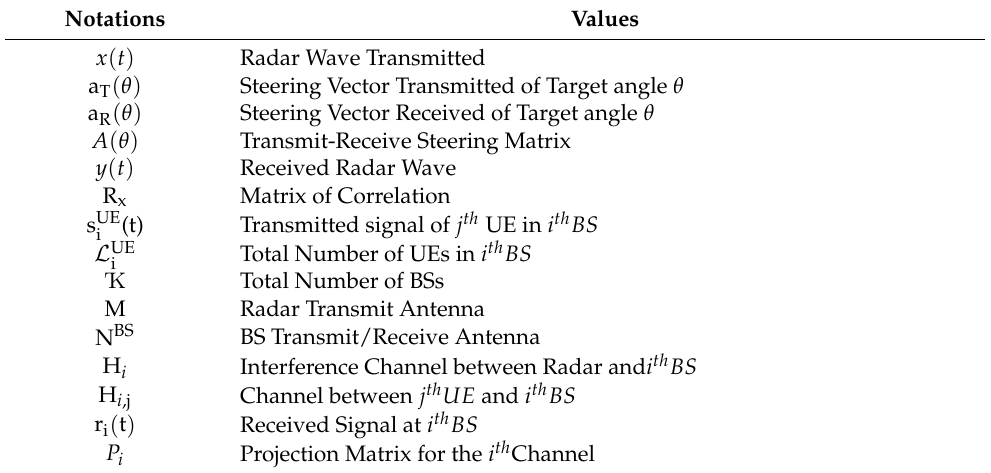
Table 1. Summary table of